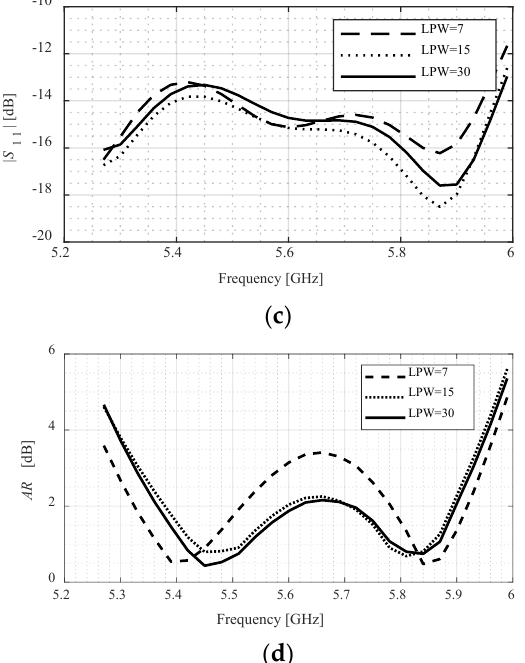
Figure 1. Circularly-polarized patch antenna; EM responses for various simulation model fidelities: ( a ) antenna structure, ( b ) the increasing trend of the simulation time as proceeding towards higher fidelities, ( c ) reflection responses for various fidelity levels, ( d ) axial ratio responses for various fidelity levels. Table 1. Benchmark antenna structures.